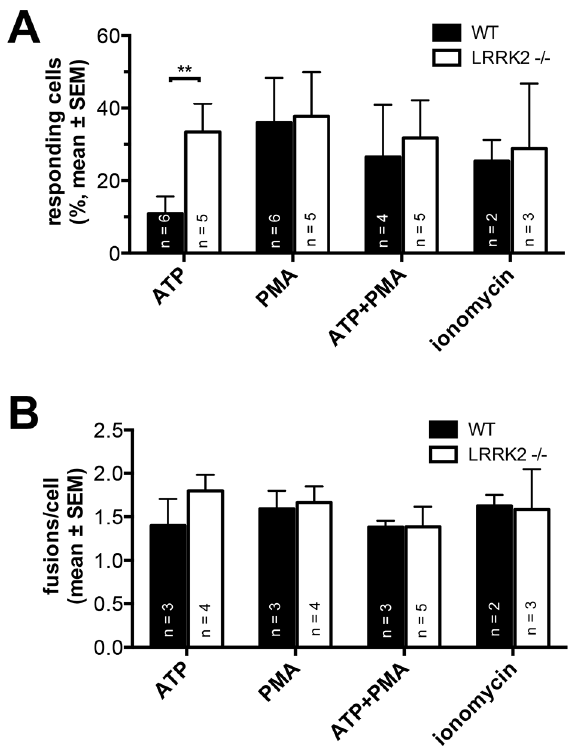
Figure 3. ATP stimulation results in an increased fusion response in LRRK2 -/- cells. Response is expressed as the fraction of cells with at least 1 fusion within 10 min of stimulation (A), and as a number of fusions/cell in responding cells (B). n denotes number of animals. Equal numbers of experiments were conducted in each animal. (Figure 4). Overall [Ca 2 + ] c kinetics were comparable between LRRK2 -/- and wt cells following various modes of stimulation (Figure 4A-D). However, in addition to increasing the number of responding cells stimulation with 100 m M ATP also resulted in a significant left shift in the fusion delay histograms (p , 0.0001, median delay was 102 s and 37 s for wt and LRRK2 -/- respectively), indicating a pronounced ‘‘triggering’’ of the onset of LB fusions (Figure 4A right). Fusion kinetics in cells stimulated with 100 m M ATP and 300 nM PMA, 300 nM PMA or 1 m M ionomycin were not significantly different in LRRK2 -/- and wt cells (Figure 4B–D, p= 0.17, 0.21, and 0.10, respectively). LB fusion activity is intimately linked to [Ca 2 + ] c [34,42,49].